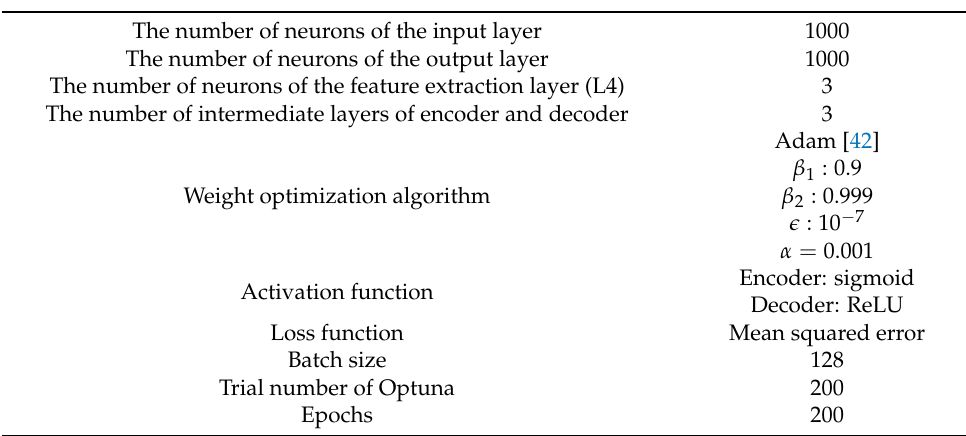
Table 2. Preset parameters for the deep autoencoders. The number of neurons of the input layer 1000 The number of neurons of the output layer 1000 The number of neurons of the feature extraction layer (L4) 3 The number of intermediate layers of encoder and decoder 3